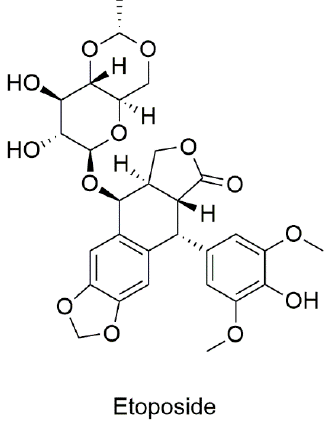
Figure 5. Chemical structure of etoposide.